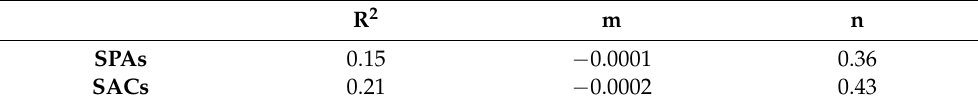
Table 5. Regression parameters of the relationship between the values of IFI and